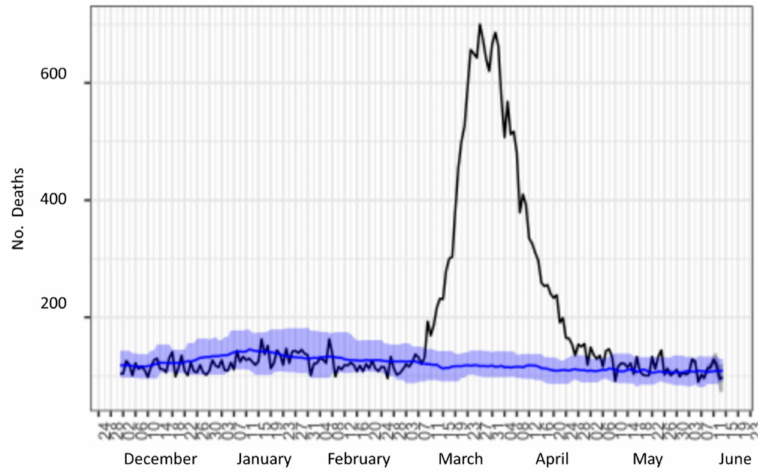
Figure 2. Mortality from all expected and observed causes in the community of Madrid (blue shading represents the average evolution of the previous 10